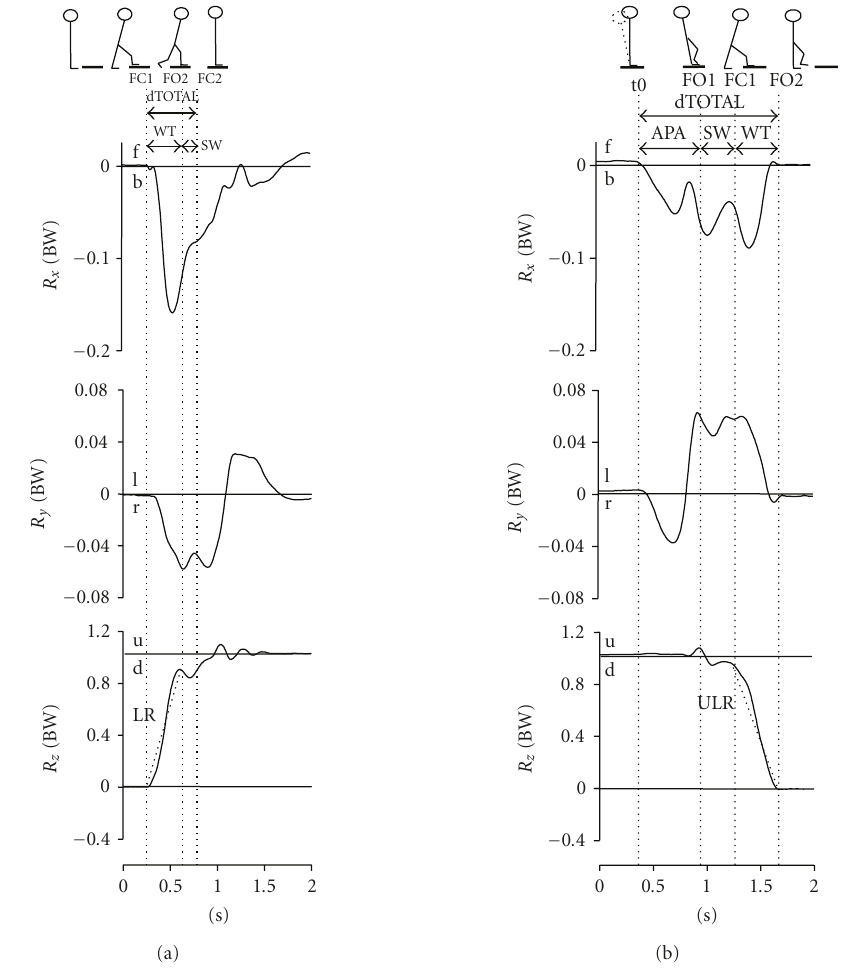
Figure 4: Biomechanical data obtained from a force plate for a typical control subject during stepping up and stepping down. R x , R y , R z : GRF normalized to body weight for AP, ML, and vertical directions. (f: forward, b: backward, l: left, r: right, u: upward, d: